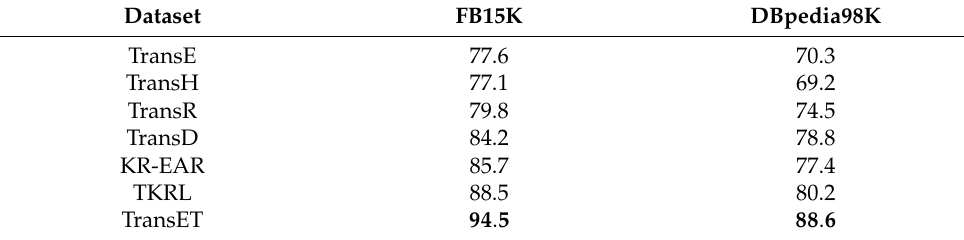
Table 5. Accuracy of triple classification